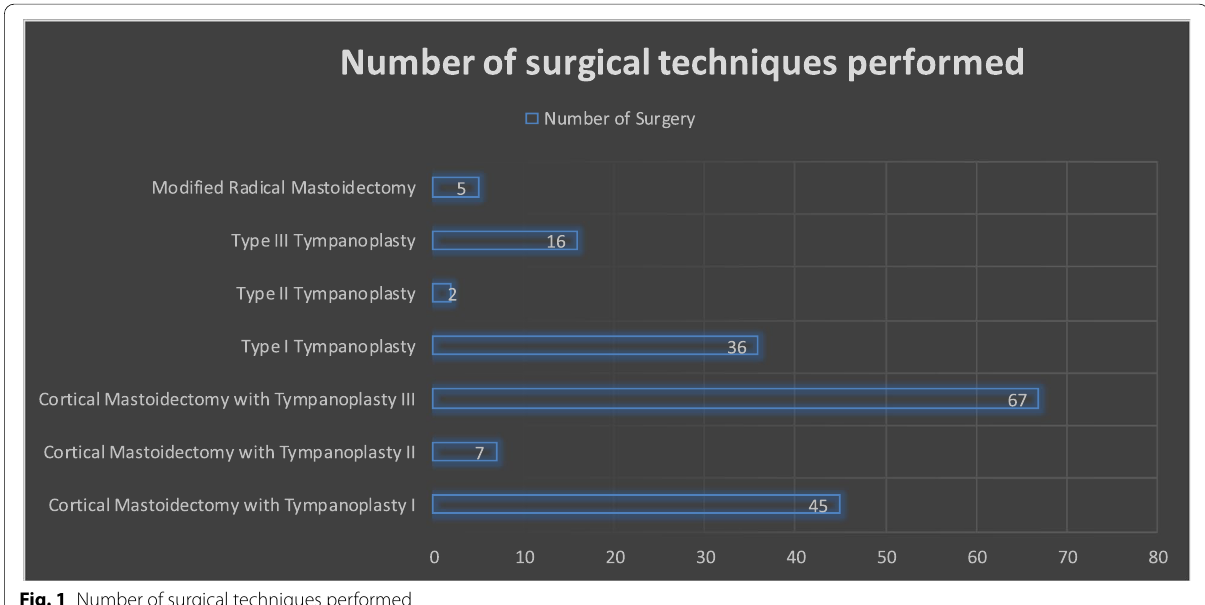
Fig. 1 Number of surgical techniques performed